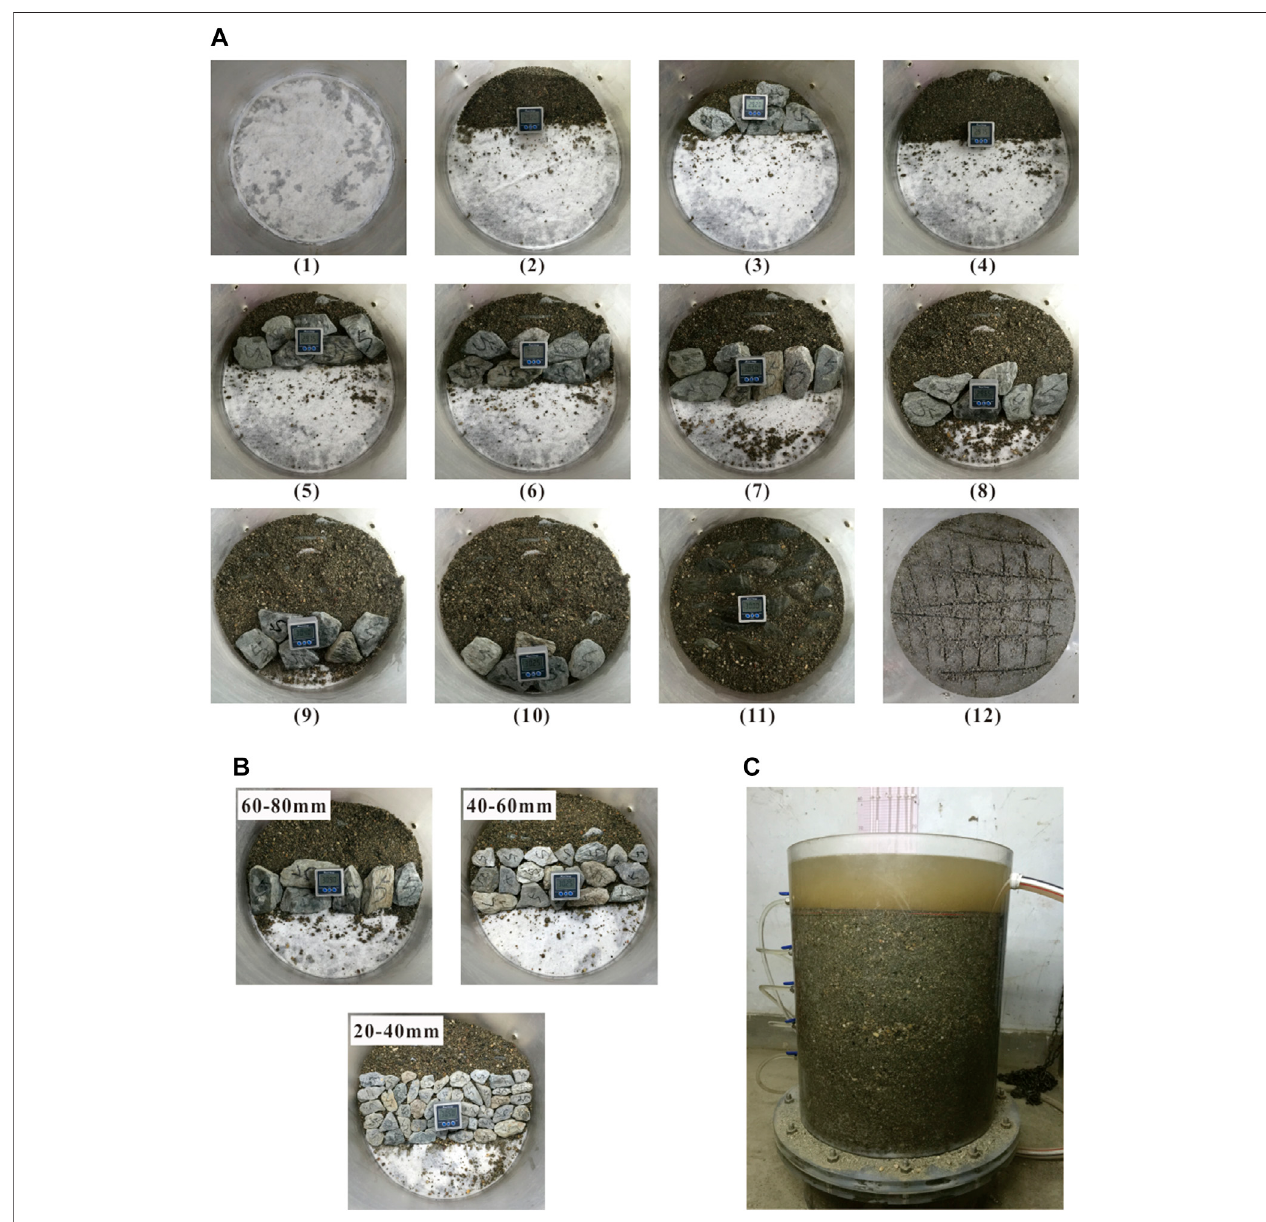
FIGURE7| Specimenpreparationprocess. (A) Preparationprocessoflayer5:Step1 – 12; (B) Specimenswithdifferentblockssize; (C) phyllitebimrockspecimens for permeability test.